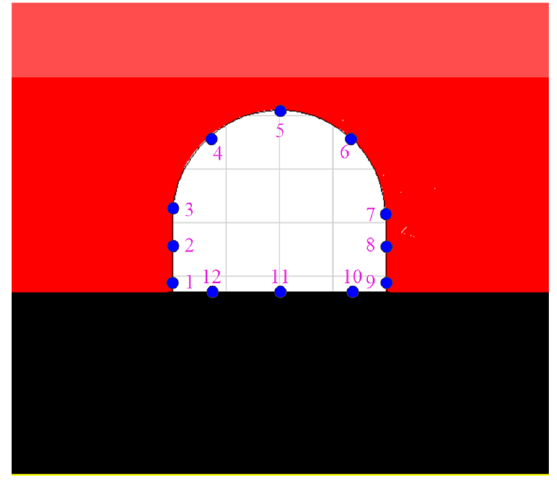
Figure 9. Layout of displacement measuring points.